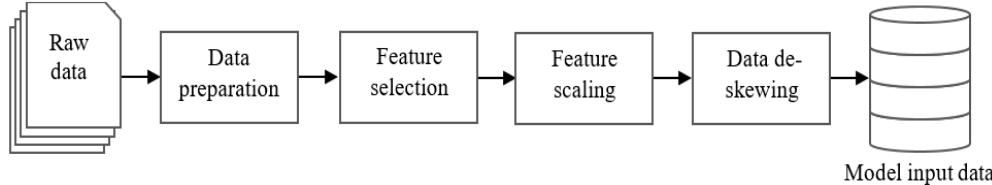
Figure 1. Data preprocessing steps.